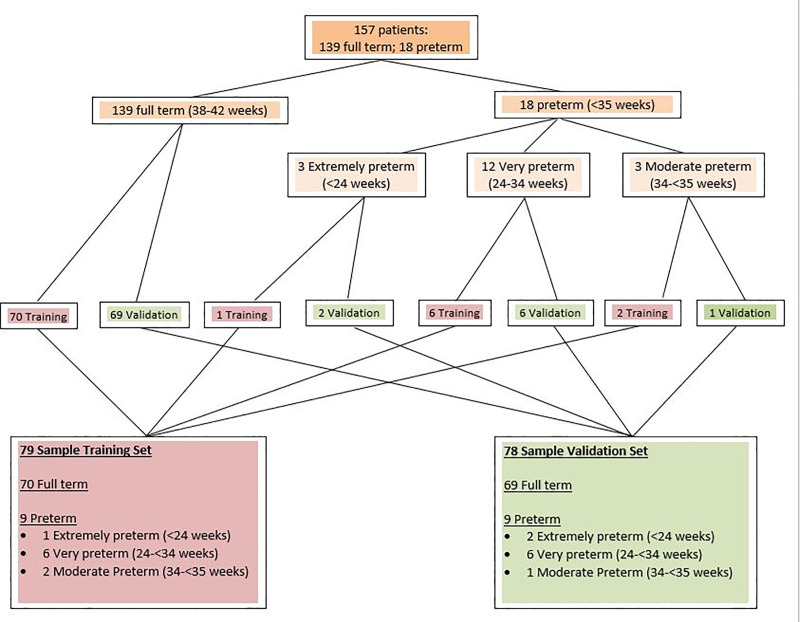
Assignment of samples to training and validation sets.The 157 samples that met the study entry criteria were randomly assigned to training and validation sets. To help assure that the training and validation sets were relatively equivalent, the preterm pregnancies were separately randomized by preterm subgroup: 1) very early preterm (<24 weeks), 2) early preterm (24–34 weeks), and 3) preterm (34–35 weeks). The 79 sample training set was used to develop the microRNA scoring system that was later applied to the 78 sample validation set.